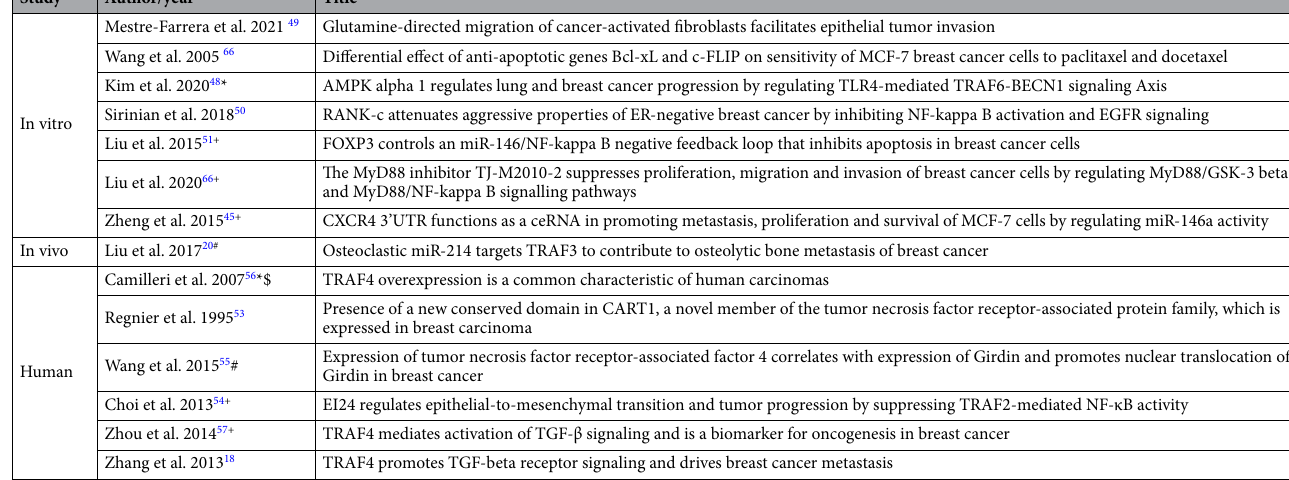
Table 5. Articles included in the narrative synthesis. + Data extracted but not pooled in meta-analysis; *data not extracted; $ in vivo data analysed by narrative synthesis. # Human data analysed by narrative